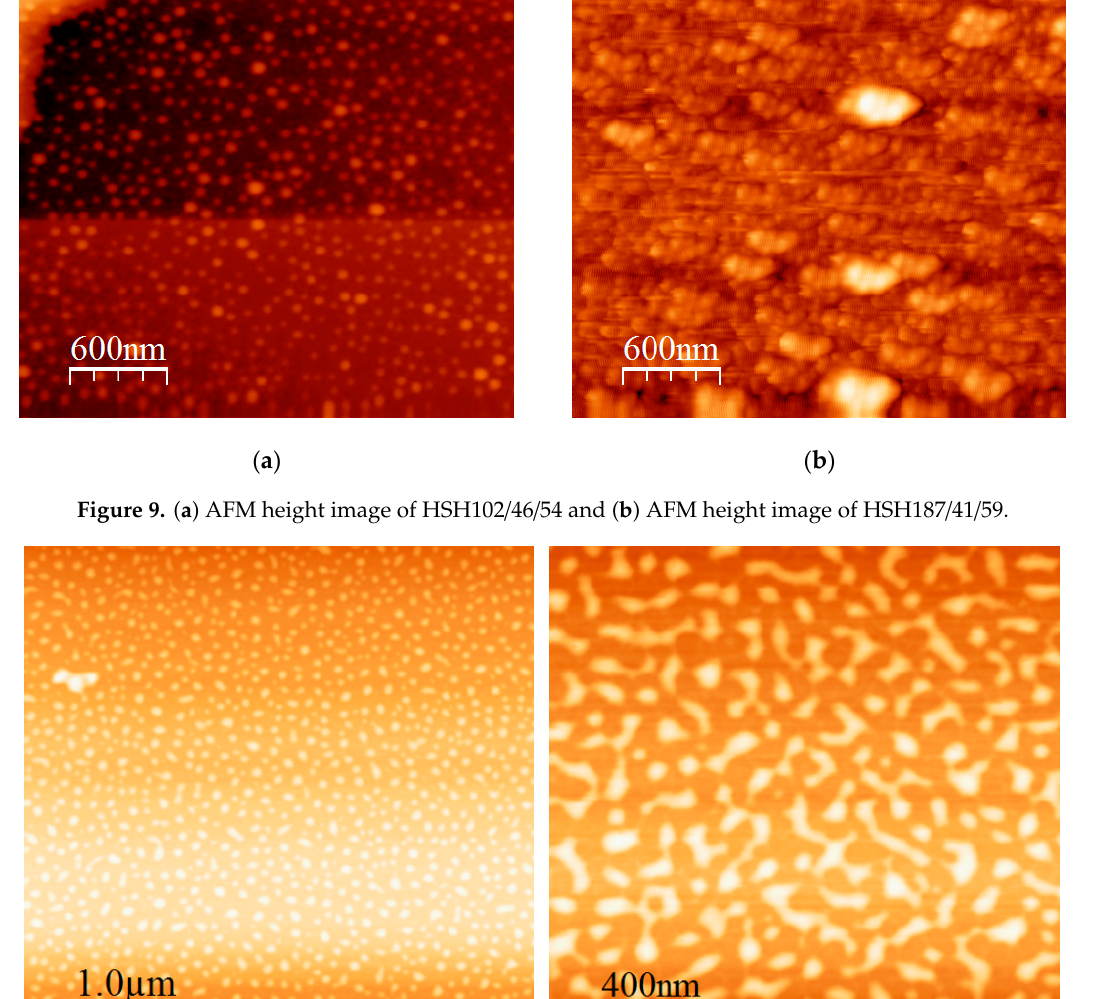
( b ) Figure 8. ( a ) Atomic force microscopy (AFM) height image of SH7.5/9/91 and ( b ) AFM height image of SH14/18/82. Spherical, relatively monodisperse, micelles are obtained in the case of the HSH102/46/54 sample, as shown in Figure 9a confirming the DLS data. Using a more concentrated solution of sample HSH187/41/59 in n-heptane, a similar picture was observed (Figure 9b). However, in this case, a small tendency for clustering is obvious. This is also facilitated by the rapid evaporation of the solvent in the spin coater in order to prepare the film for AFM observation. More interesting results were obtained in the case of the HIH triblock copolymer in n-dodecane. Small spherical structures